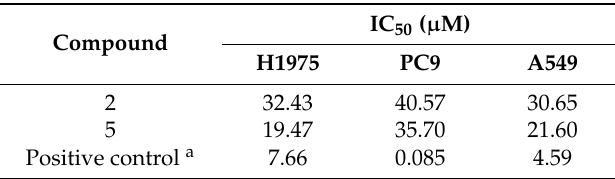
Table 4. Cytotoxic activities of compounds 2 and 5 .